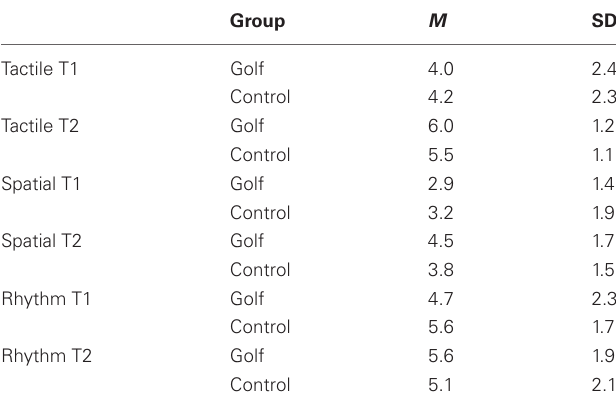
Table 1 | Self-report of the imagery